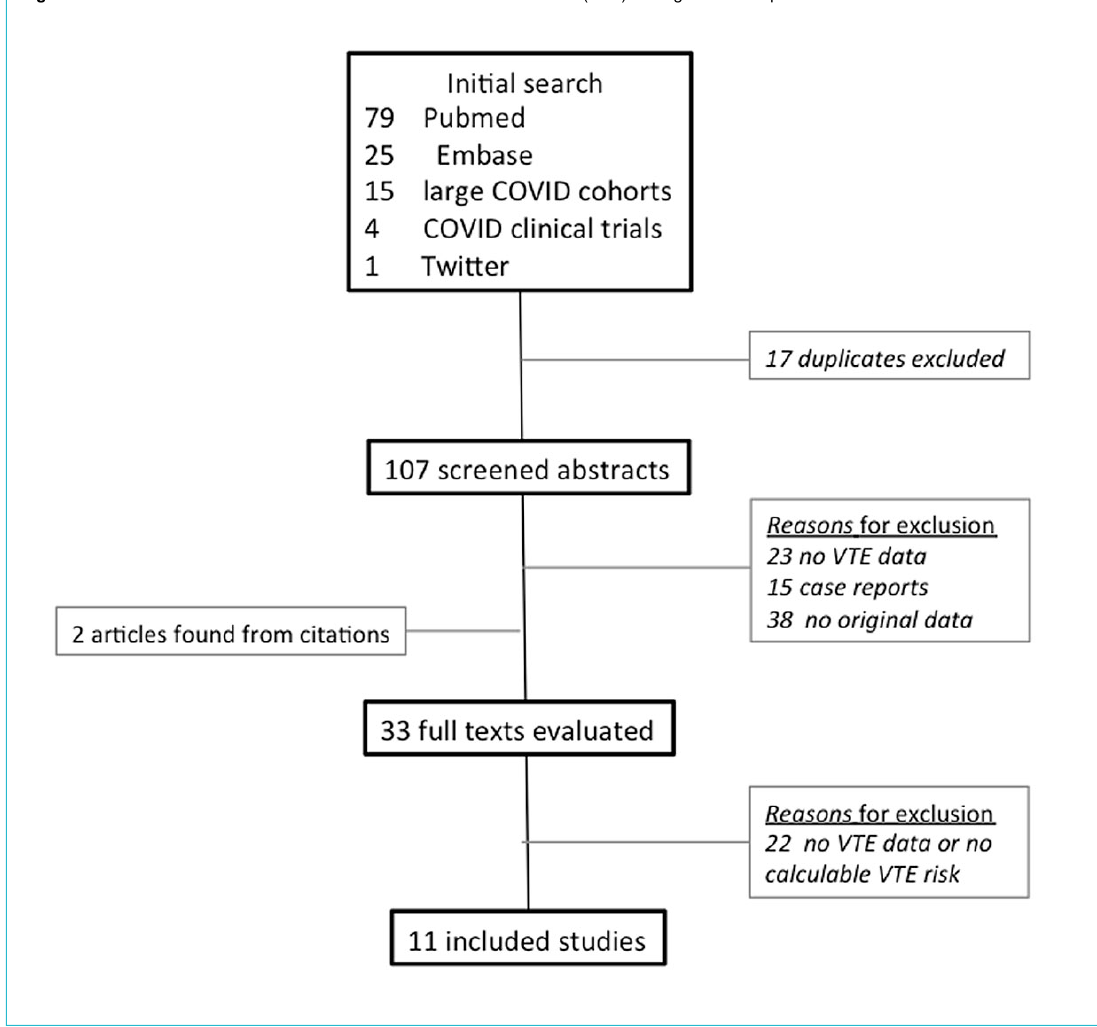
Figure 1: Flow-chart of the search for the risk of venous thromboembolism (VTE) among COVID-19